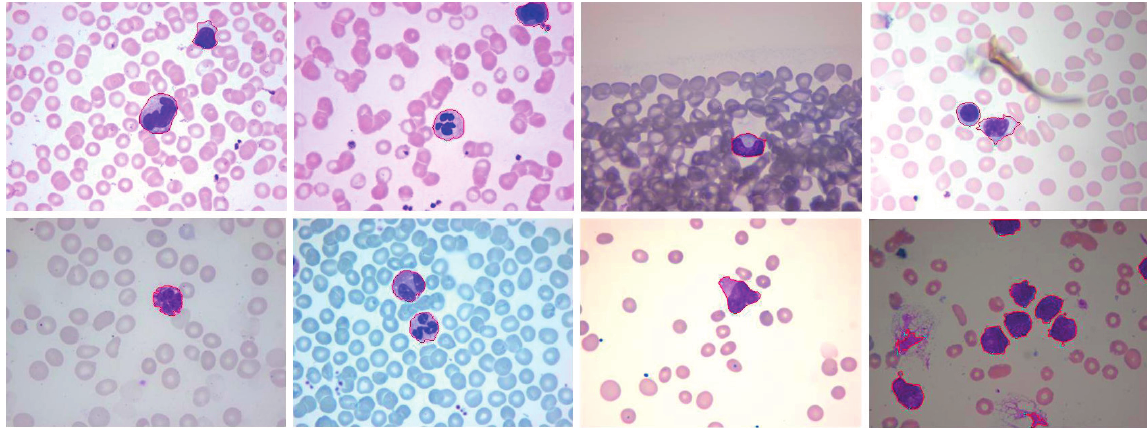
Figure 13. Segmented results for WBCs with 1 monocyte, 1 staff neutrophil, 2 segmented neutrophils, 1 basophil, 1 eosinophil, 4 lymphocytes, and 9 AML cells (segmented WBCs are marked with red